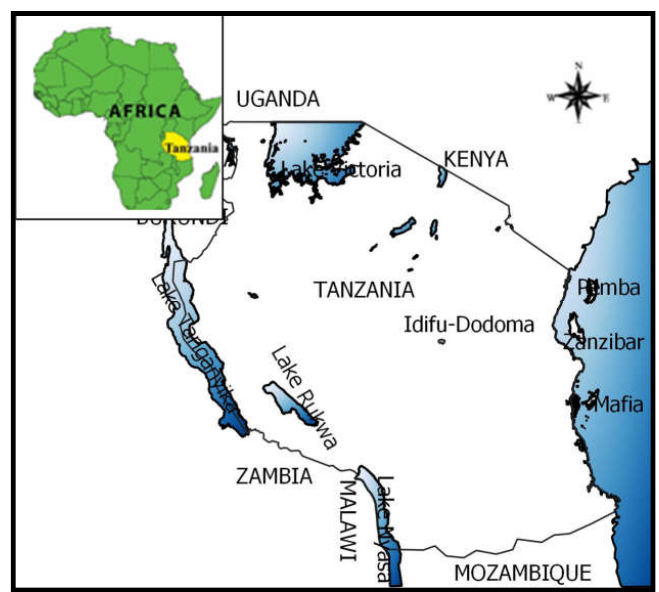
Figure 1. Location of the study site.